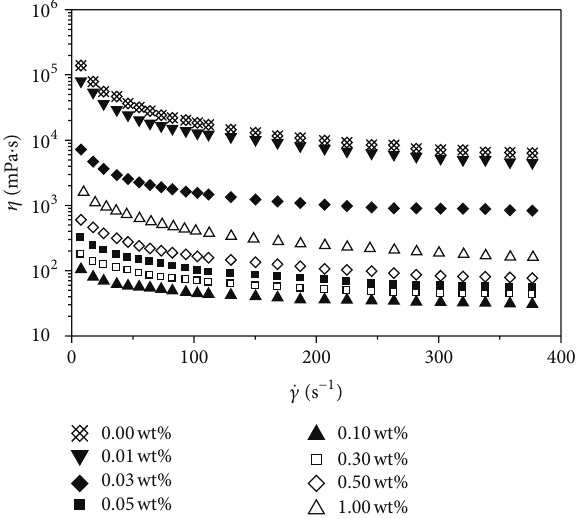
Figure 1: Apparent viscosity ( 𝜂 ) versus shear rate ( ̇𝛾 ) flow curves for the 77.5 wt% alumina + sodium tripolyphosphate suspensions